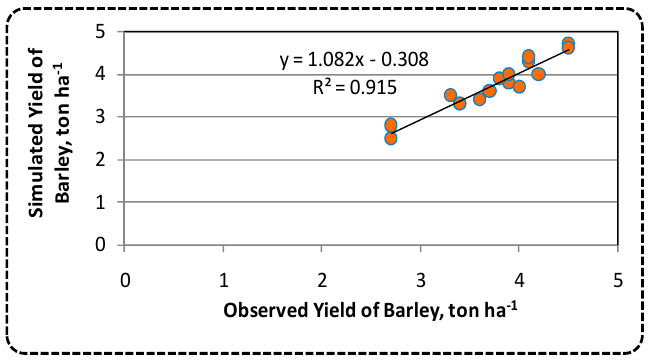
Figure 15. Observed versus simulated yield for all treatments for seasons 2017/2018 and 2018/2019.